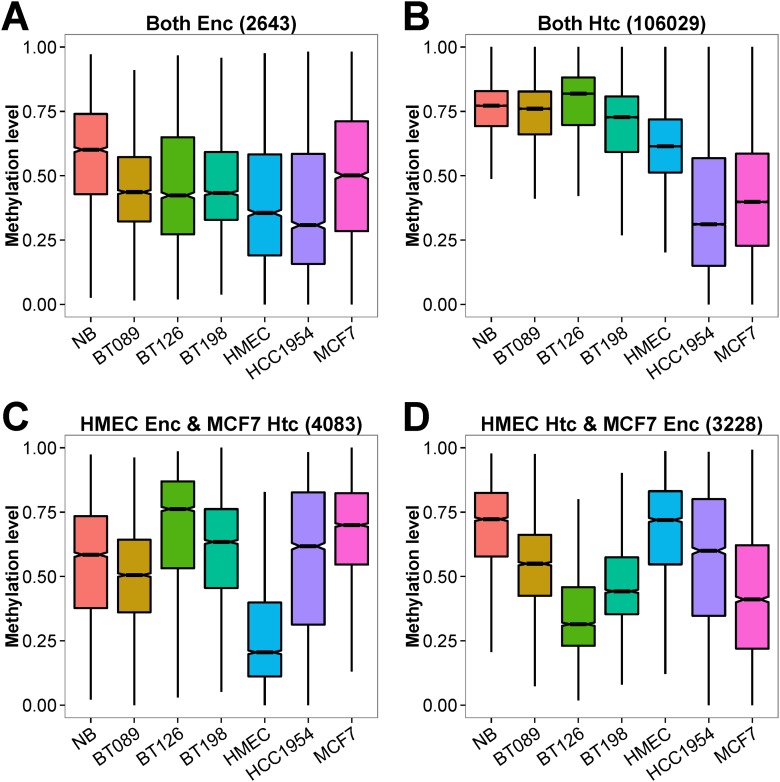
Distribution of DNA methylation levels of MCF7 and HMEC enhancers and/or heterochromatins in the seven breast methylomes.The genomic regions characterized as enhancer (Enc) or heterochromatin (Htc) in HMEC and MCF7 by ChromHMM were re-annotated as regions that were (A) enhancer in HMEC and MCF7 (B) heterochromatin in HMEC and MCF7, (C) enhancer in HMEC and heterochromatin in MCF7, and (D) enhancer in MCF7 and heterochromatin in HMEC.